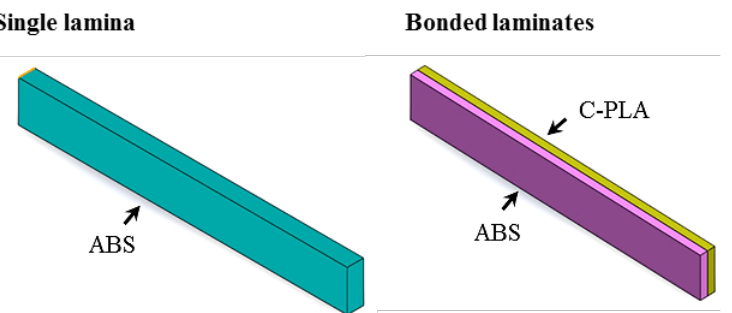
Figure 2. Schematic showing single and two bonded laminates: both types have same size. Thickness of each lamina in bonded laminates varies depending on the clade ratio as given in Section 2.4.